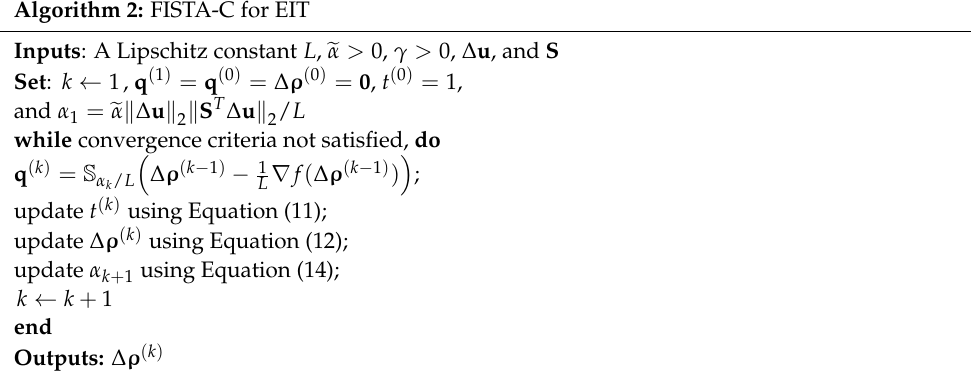
Algorithm 2: FISTA-C for